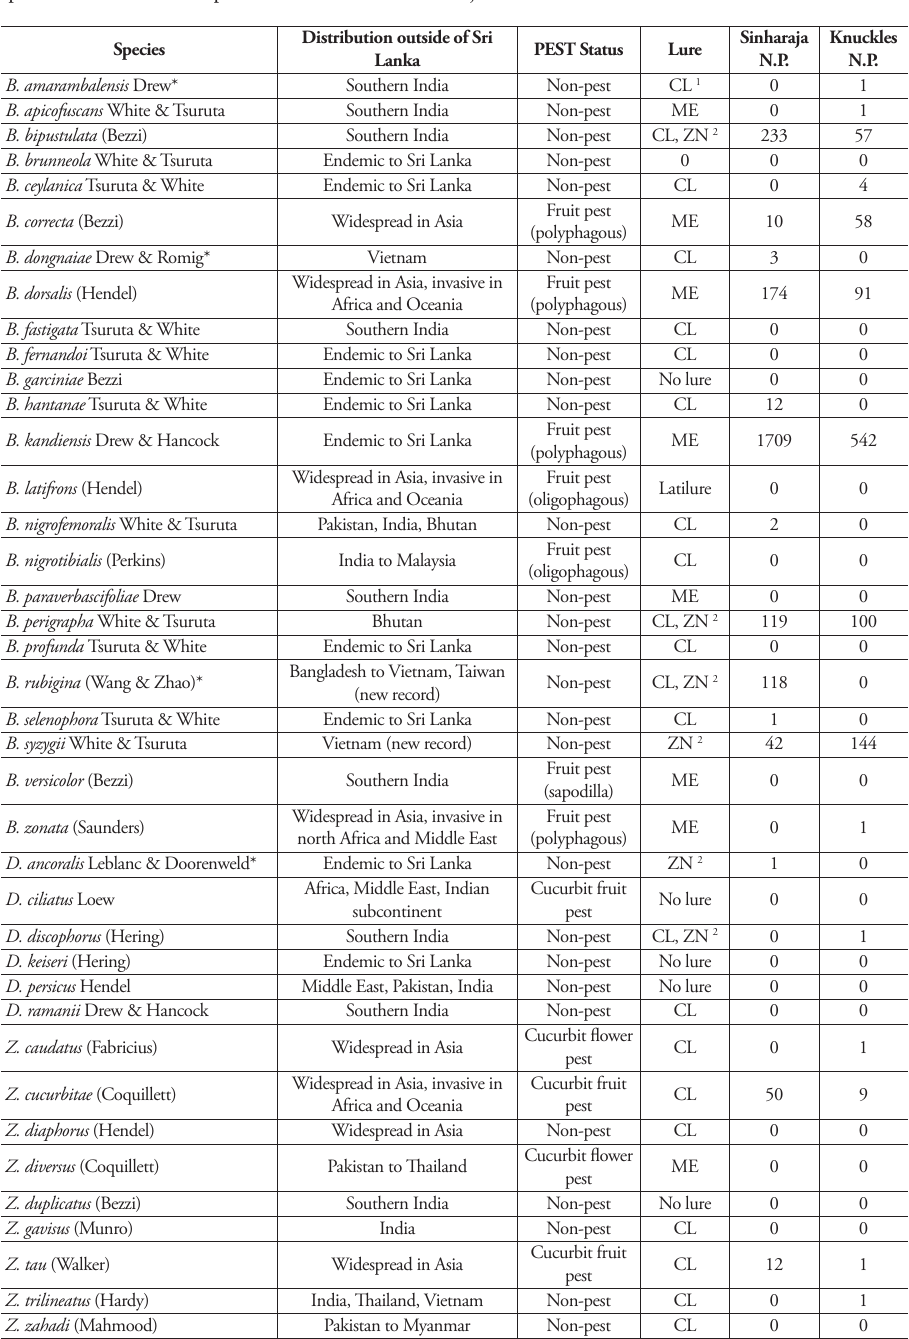
Table 1. Checklist of Dacine fruit flies of Sri Lanka, including three new country records and one new species, and number of specimens collected in Sinharaja and Knuckles National Parks in